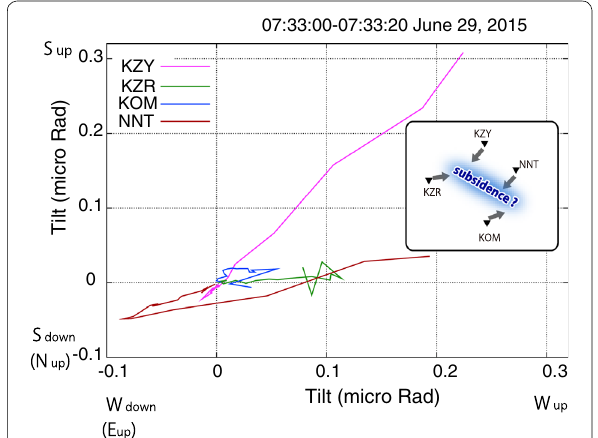
Fig. 5 Tilt motions for 20 s after 7:33 a.m. observed at borehole stations around the central cone. The direction of initial ground motions at NNT and KZY was southwest downward, whereas east or northeast downward initial motions were observed at KZR and KOM. The ground motions observed at each station reversed as time passed. These movements seem to coincide with the subsidence and uplift of the central cone. The inset shows a schematic view of the site location and tilt